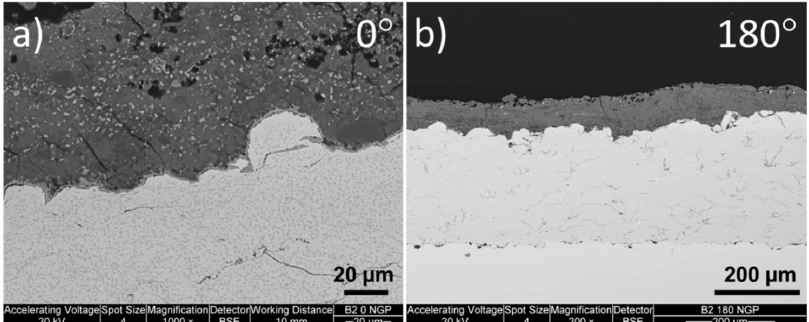
leeward side. The arrow pointing to the porous oxide scale containing zinc.